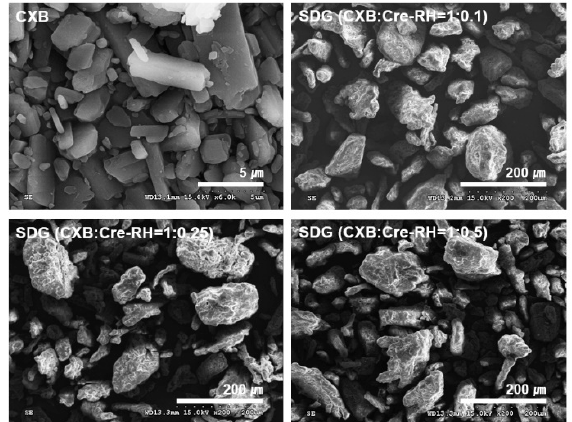
Figure 1. Scanning electron micrographs of CXB and solid dispersion granules (SDGs) with different weight ratios of CXB/Cre-RH. All the SDGs were 100–200 µ m in size with irregular appearances.